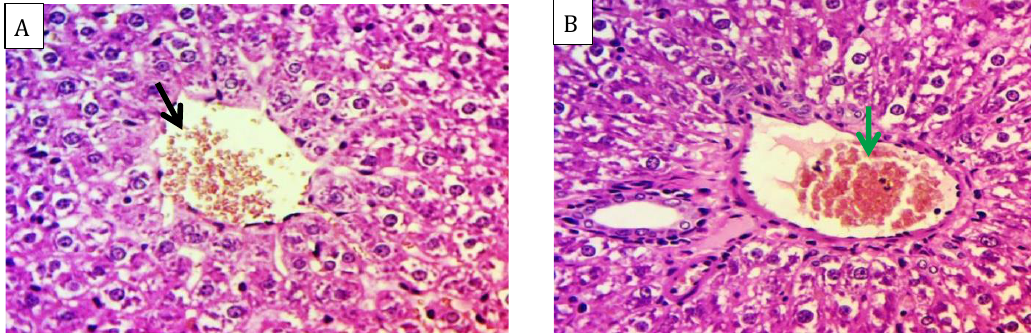
Figure 2 . Liver sections of control positive rats (Group 2, fed on 1% cholesterol diet and left without treatment). A: Congestion of the central vein (black arrow) and marked cytoplasmic vacuolation and swelling of the hepatocytes. B: Marked cytoplasmic vacuolation and swelling of the hepatocytes, and congestion of the portal vein (green arrow) associated with focal infiltration of mononuclear inflammatory cells. H&E, 400×